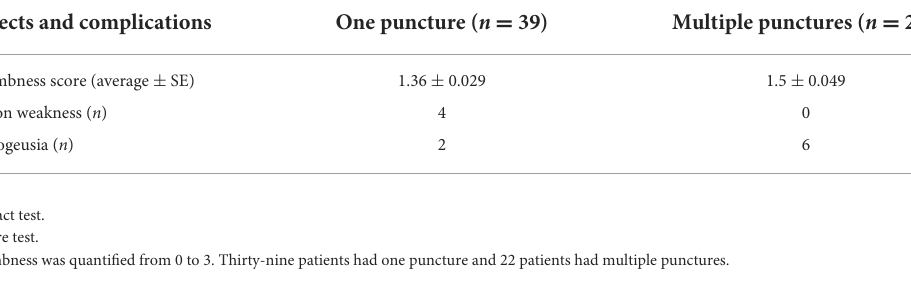
TABLE 2 Side effects and complications for one puncture and multiple